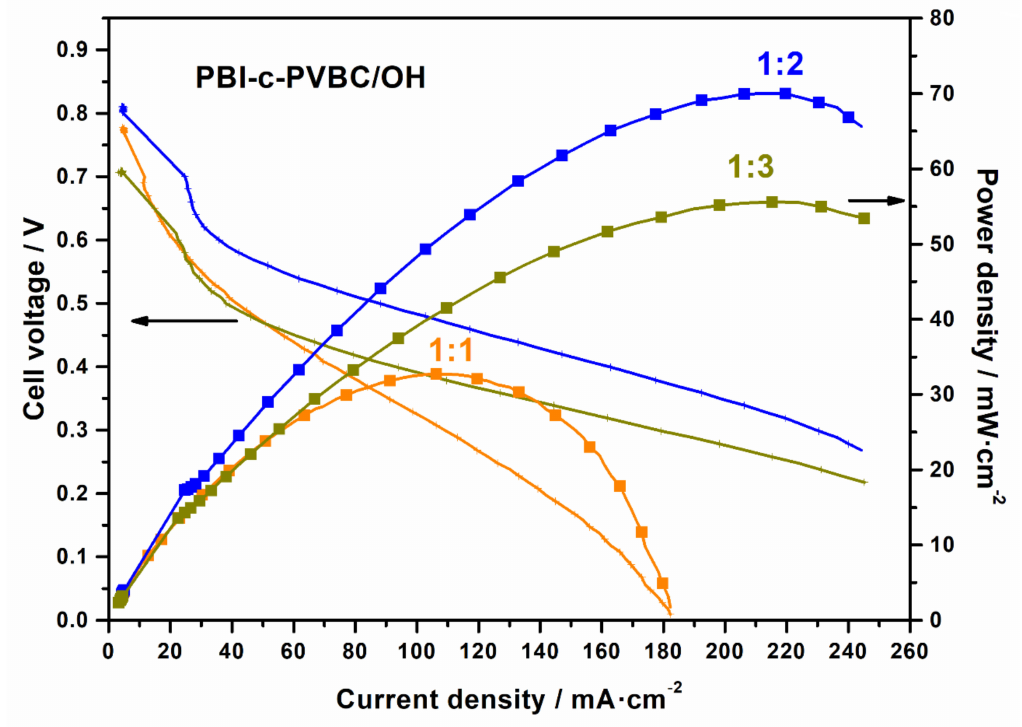
Figure 12. Fuel cell polarization (line) and power density (squares) curves for PBI-c-PVBC / OH 1:1 (orange), 1:2 (blue) and 1:3 (dark yellow) membranes. More details in Table